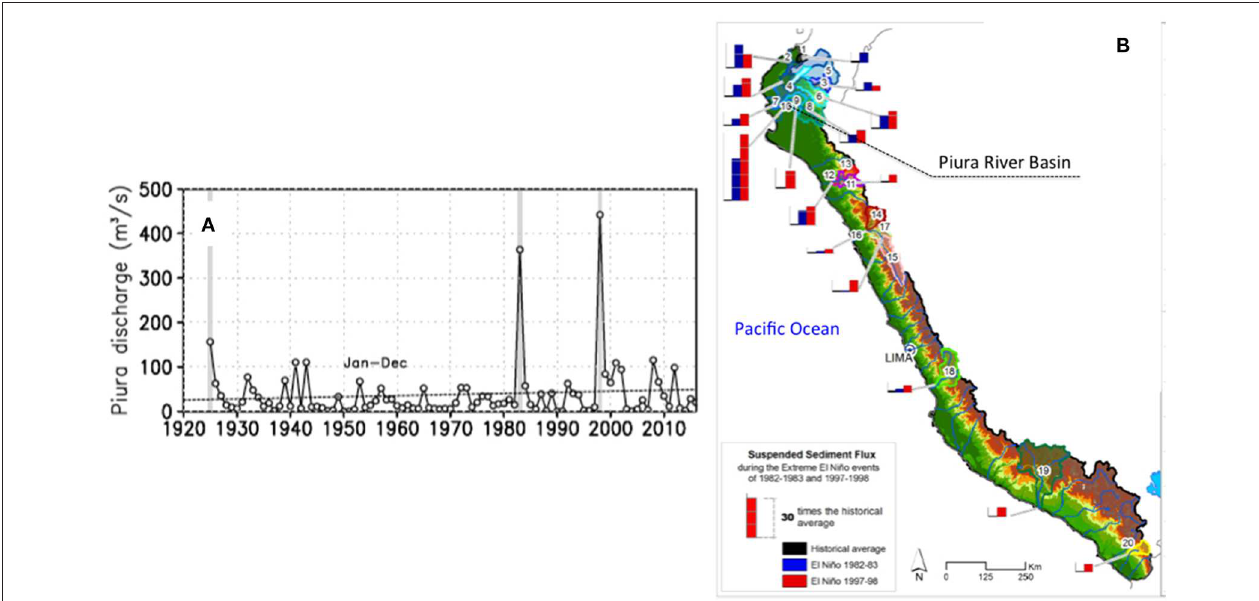
FIGURE 12 | (A) January-December mean discharge of the Piura River during the 1925–2015 period. The linear trend is indicated in dashed line. Vertical gray lines indicate the strong El Niño events of 1925, 1983, and 1998. Adapted from Takahashi and Martínez (2019). © Springer Nature. CC license. (B) Suspended sediment flux observed in the Peruvian coast. Black bars represent climatological sediment flux, red and blue bars display sediment flux during El Niño years of 1982–83 and 1997–98, respectively. Each cube on the bar represents the sediment flux transported over 10 normal years. Adapted from Morera et al. (2017). © Springer Nature. CC